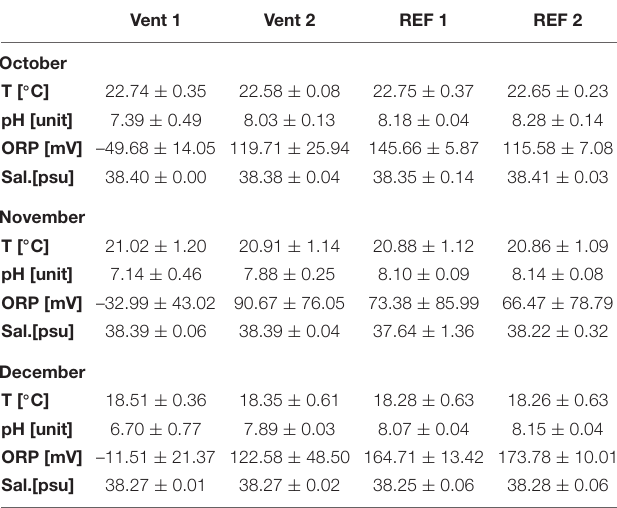
TABLE 1 | Physicochemical parameters of the study sites for the duration of the experiment.